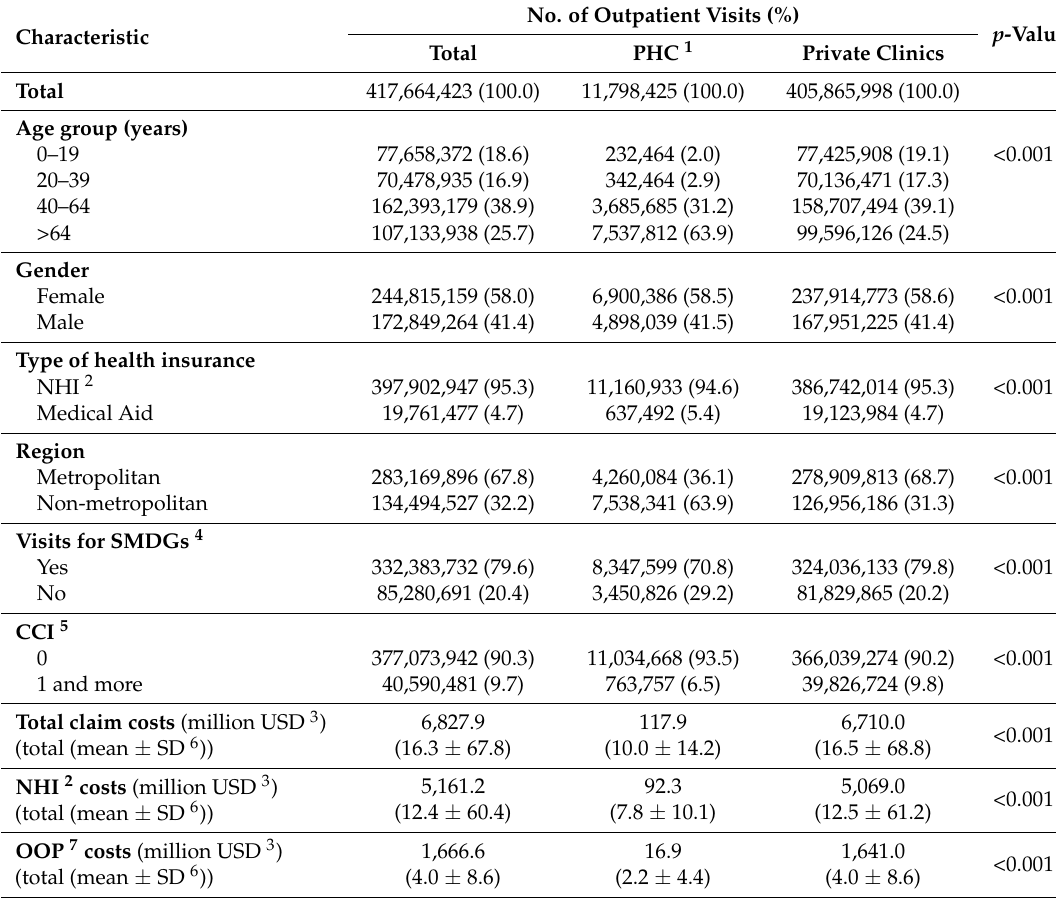
Table 1. Characteristics of outpatient visits in the public health clinics and private clinics.